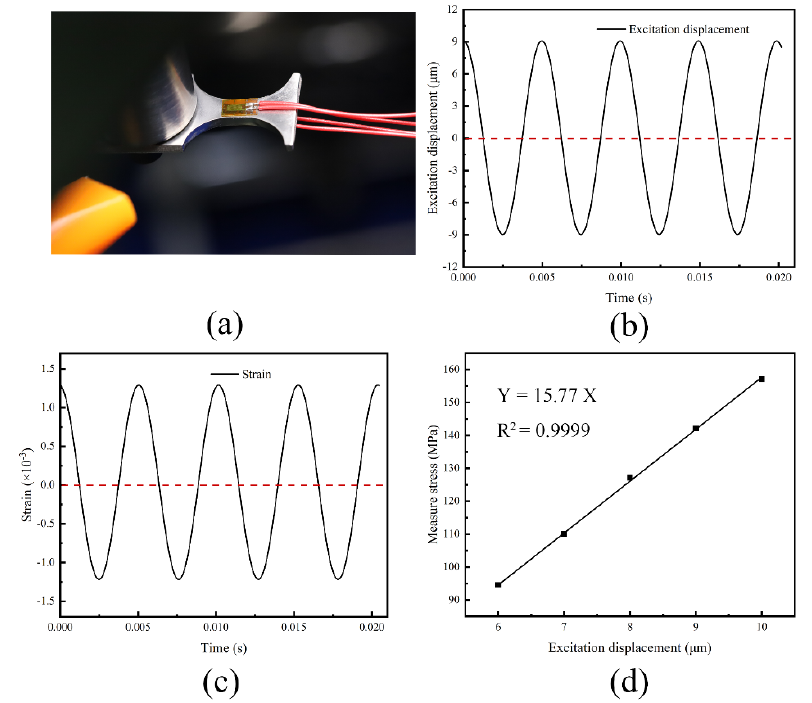
Figure 4. Strain measurement: ( a ) diagram of strain gages; ( b ) waveform of excitation displacement; ( c ) waveform of measured strain; ( d ) relationship between measured stress and FEA stress.